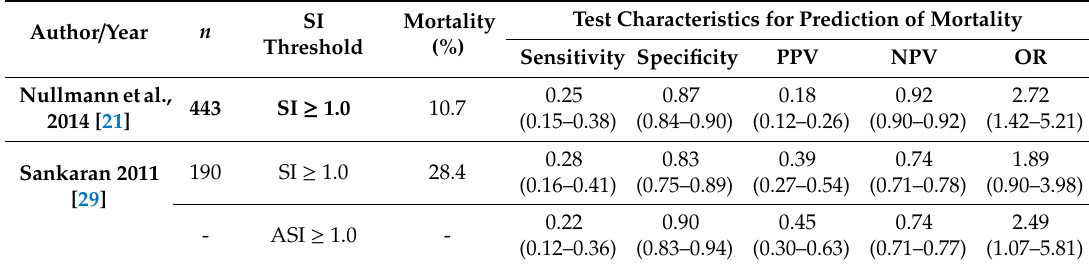
Table 3. Association between SI / ASI and mortality in patients with